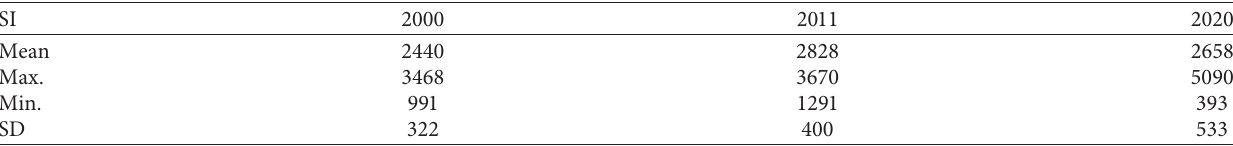
Figure 9: Satellite altimetry data plotted for year-wise showing sea level changes (in cm). Table 6: Statistics comparison table for SI of the island for 2000, 2011, and